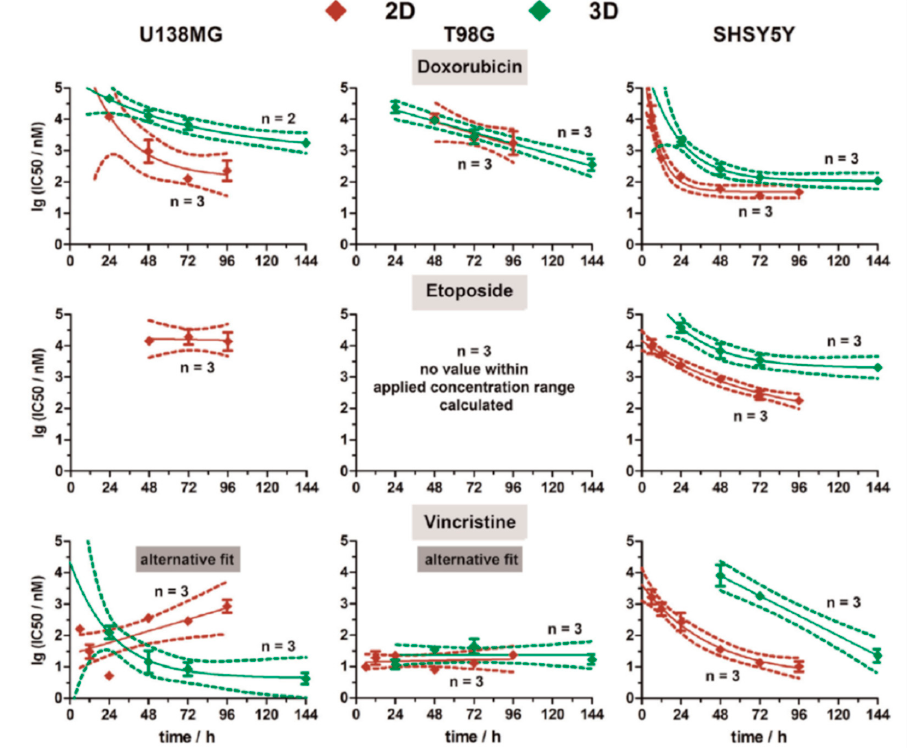
Figure 16. Comparison of IC 50 values (vincristine, doxorubicin, and etoposide) obtained from real-time impedimetric measurements on neuroblastoma (SH-SY5Y) and glioblastoma (T98G, and U138MG) 2D and 3D cell culture models. Reprinted from Eichler et al. [102] with permission from Elsevier.